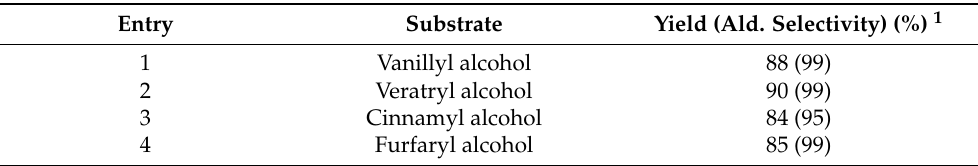
Table 2. Lignin-based oxidation of different substrates.